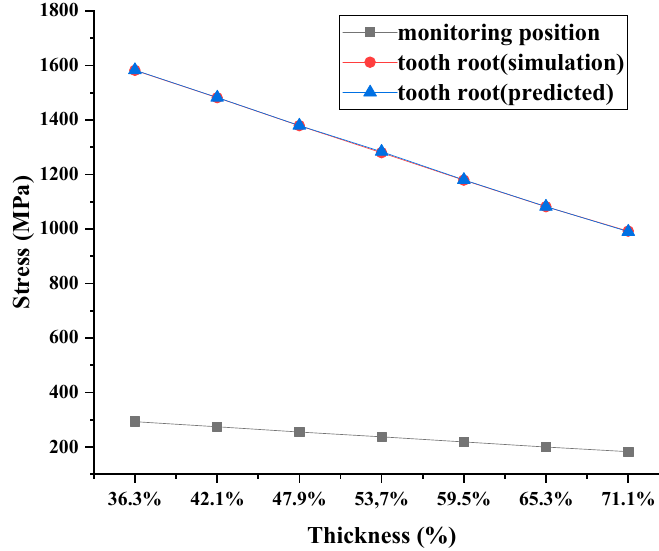
Figure 22. The influence of thickness of spoke plate changes on gear stress.